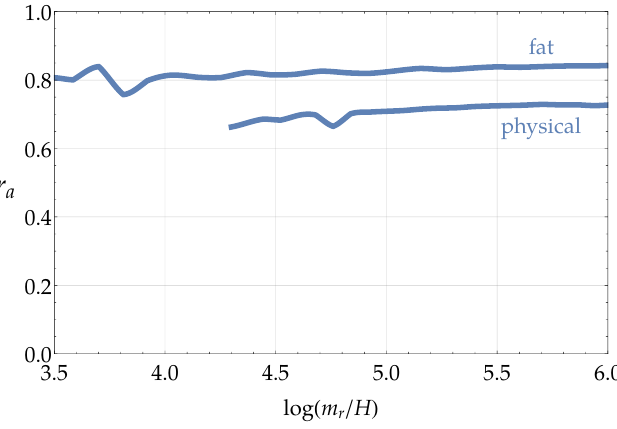
Figure 9 . The fraction of the instantaneous energy density emitted by strings that is converted into axions (as opposed to radial modes) r a = (cid:0) a = (cid:0) as a function of time, for the fat string and the physical simulations. At late times more than 70% (80%) of the energy released from the string network in the scaling regime goes into axions in the physical (fat string) case. The rest of the energy goes into the production of massive radial mode